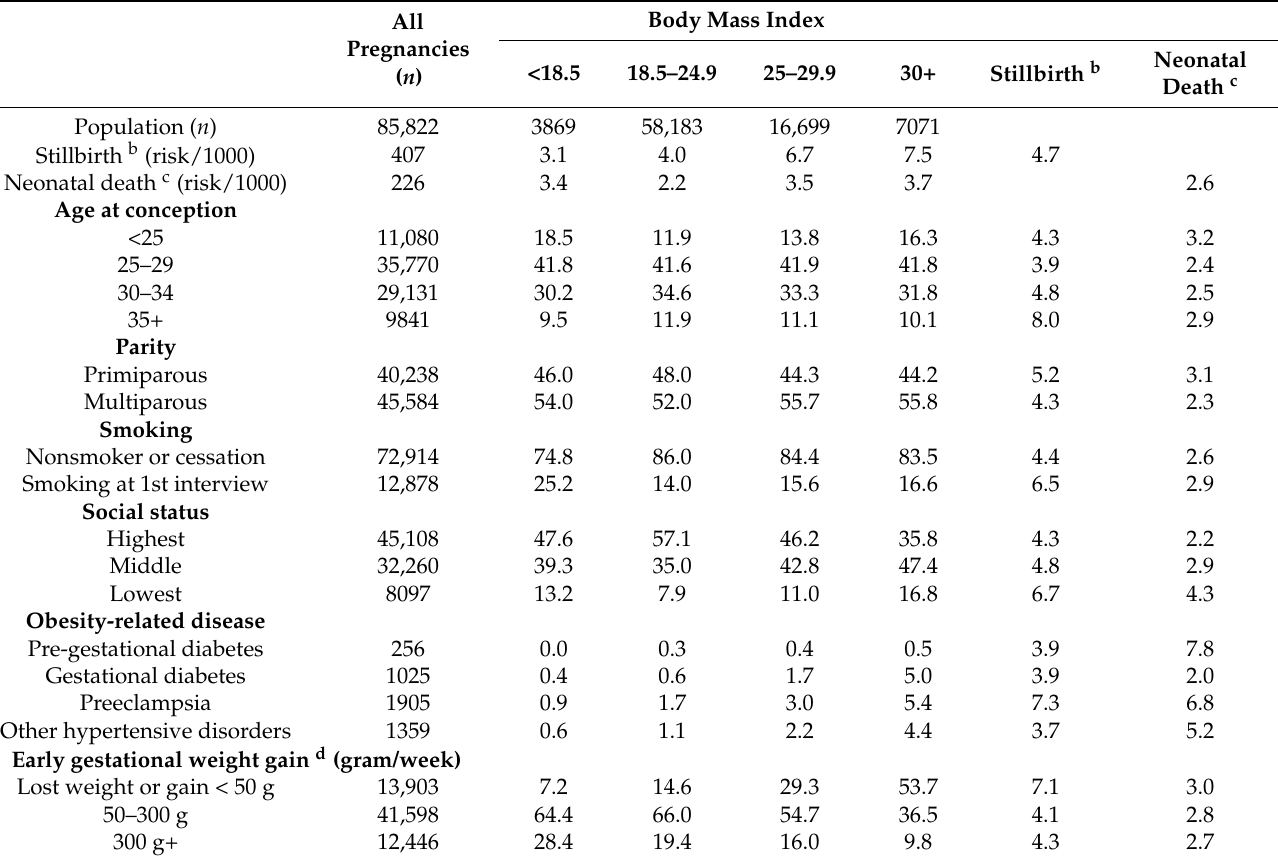
Table 2. Maternal and neonatal characteristics of 85,822 pregnancies a by body mass